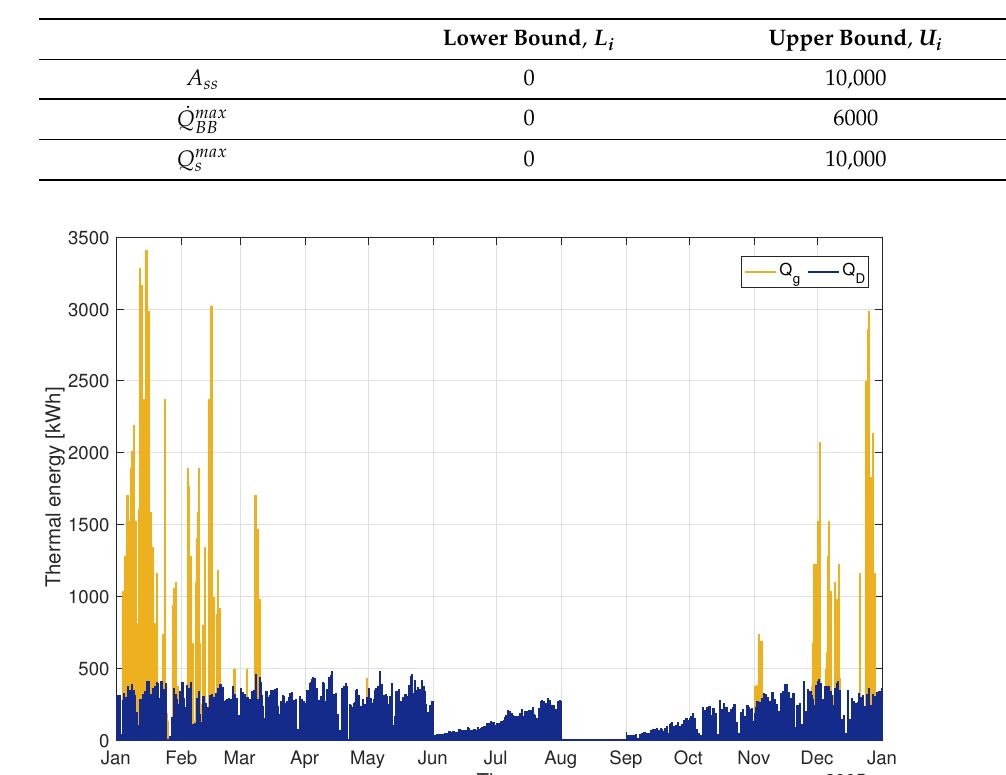
Table 2. The upper and lower bounds used in the optimization problem.